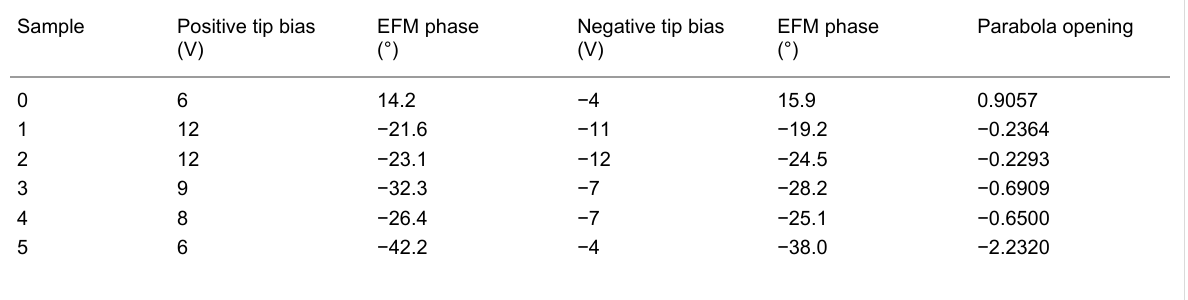
Table 2: Peak EFM phase, the corresponding tip biases used in EFM imaging, and parabola opening values (from the EFS measurements in Figure 2o).